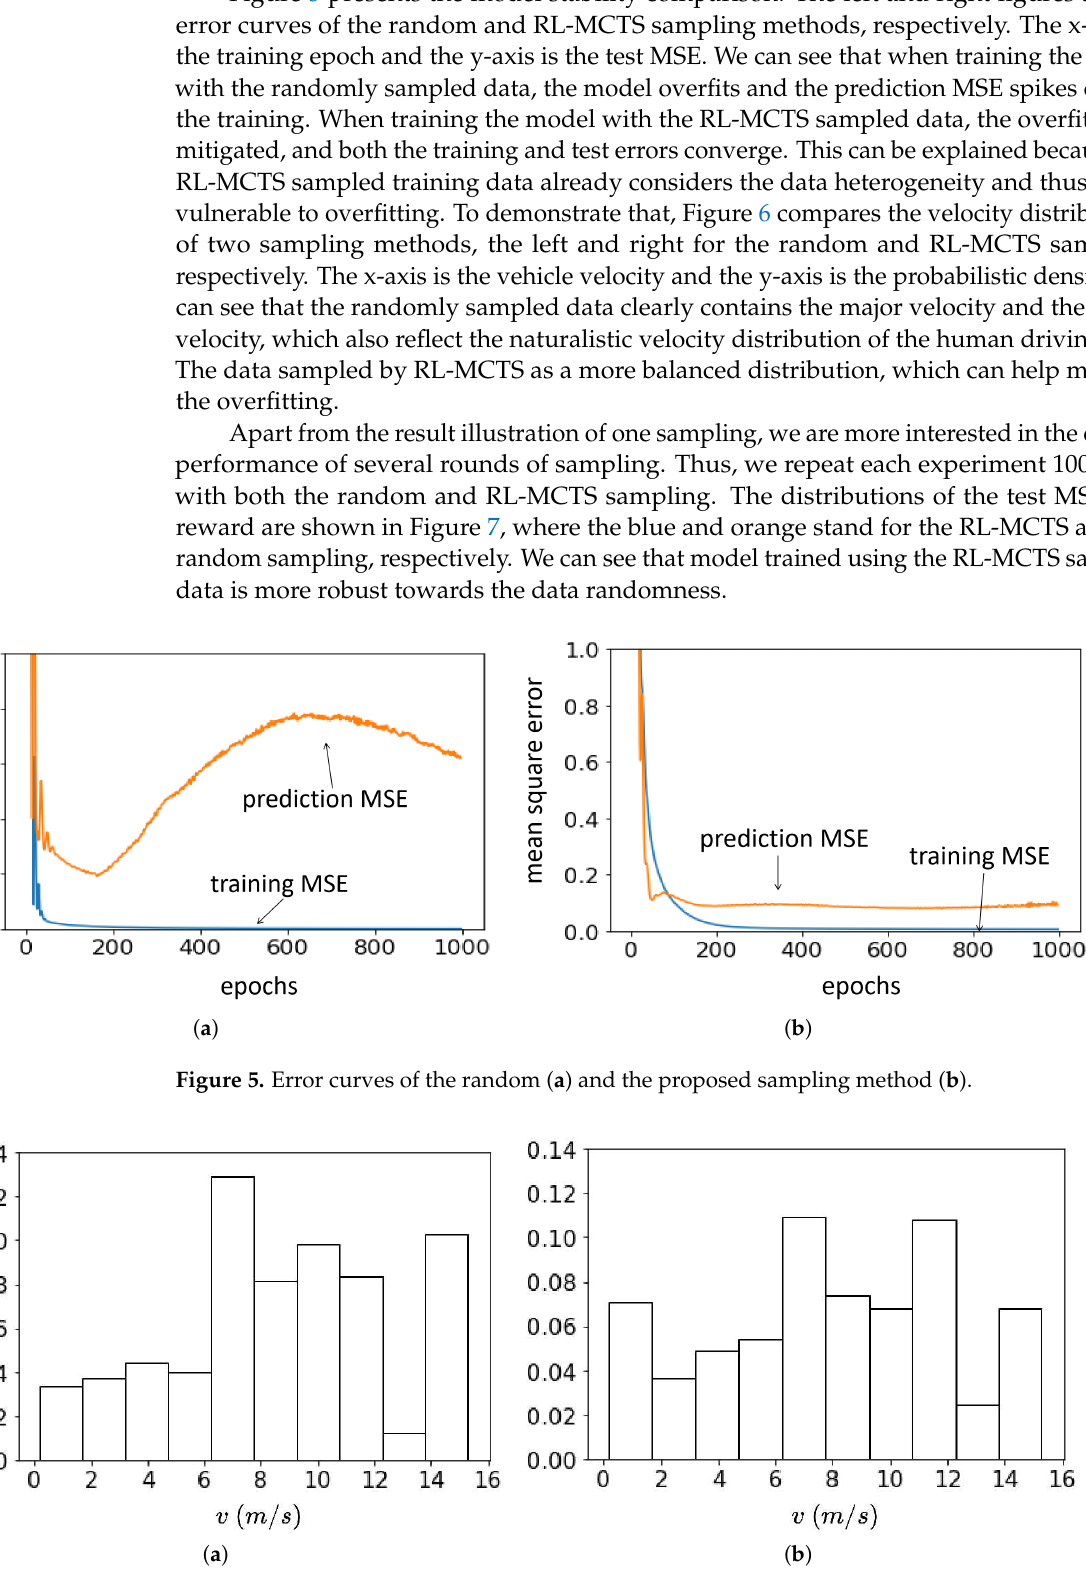
Figure 6. Velocity distributions of the random ( a ) and the proposed ( b )